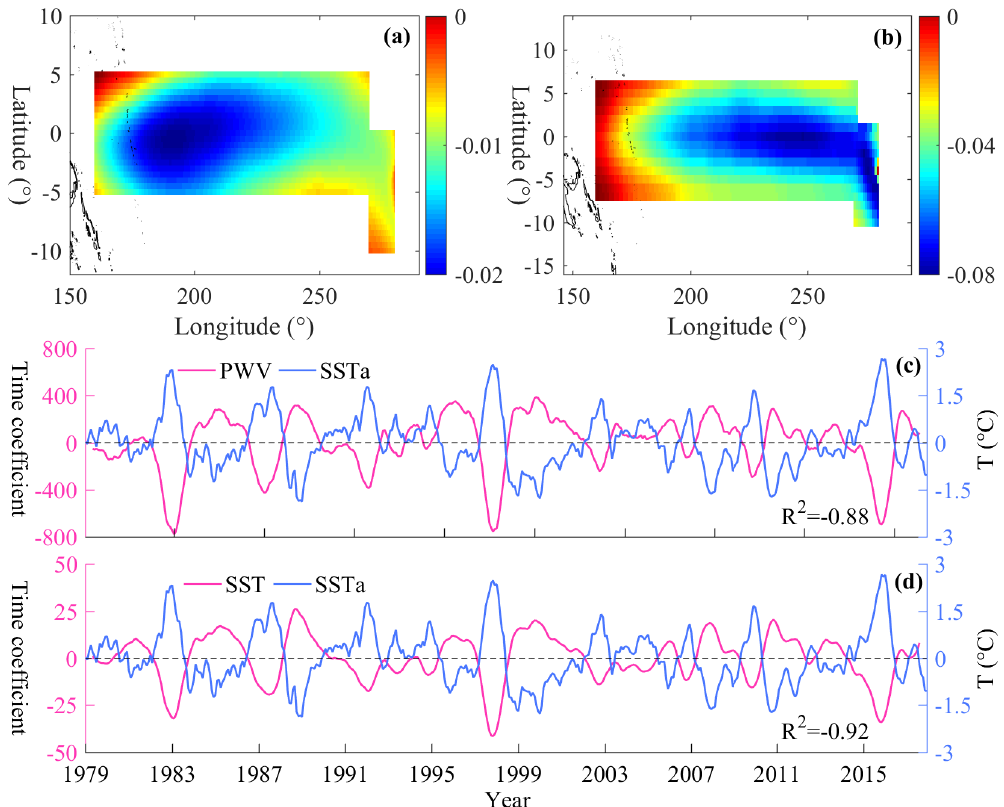
Figure 2. Spatiotemporal pattern of PWV and SST first mode, and compared with the time series of SSTA in the El Niño area over the period of 1979 – 2017, where ( a ) and ( b ) are the spatial distributions of PWV and SST first mode, respectively and ( c ) and ( d ) are the time series of time coefficients of PWV and SST first mode and SSTA, respectively.